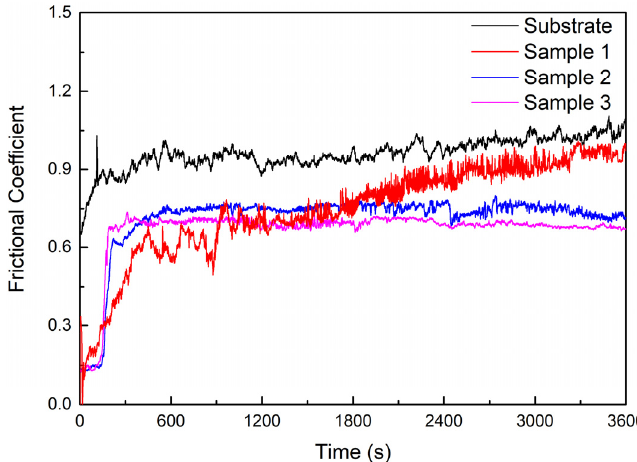
Figure 14. Friction coefficient of the substrate and cermet coatings.